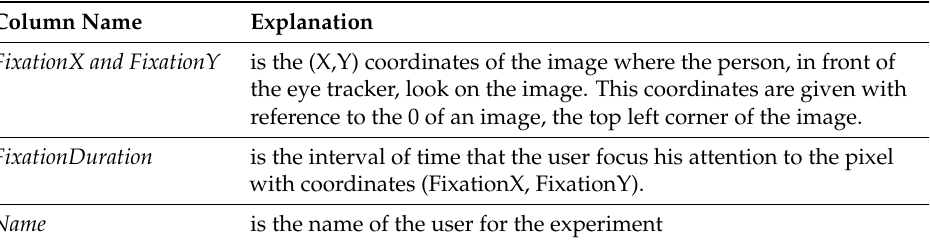
Table 1. List of the column of the data obtained from the eye